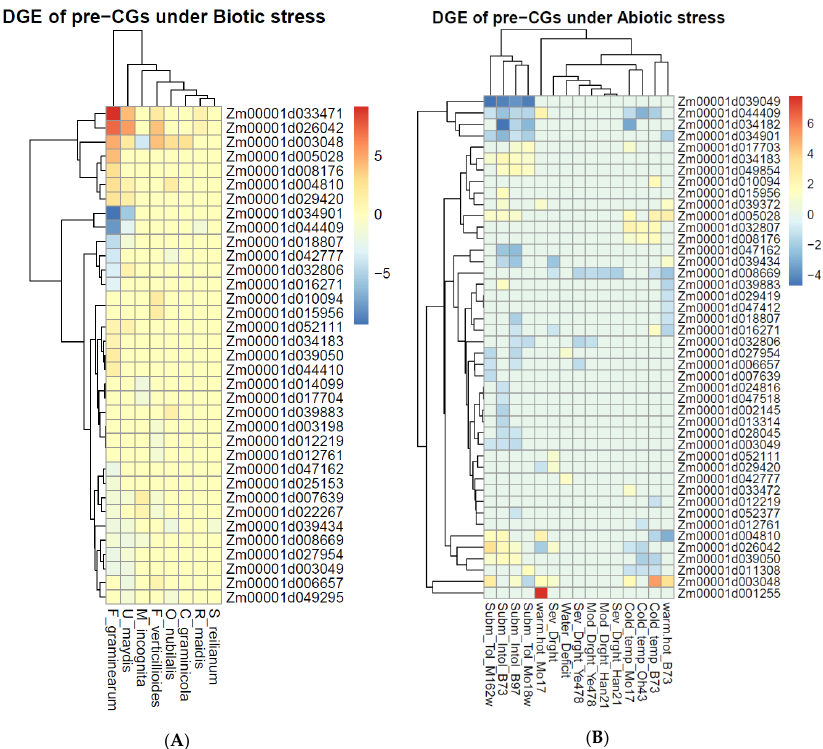
Figure 5. Differential gene expression (DGE) of pre-candidate genes (CGs) under ( A ) different biotic agents including Fusarium graminearum and verticelloides , Meloidogyne incognita , Ostrinia nubilalis , Rhopalosiphum maidis , and Ustilago maydis , and ( B ) abiotic stress conditions such as cold temperature, drought, heat, and submergence.